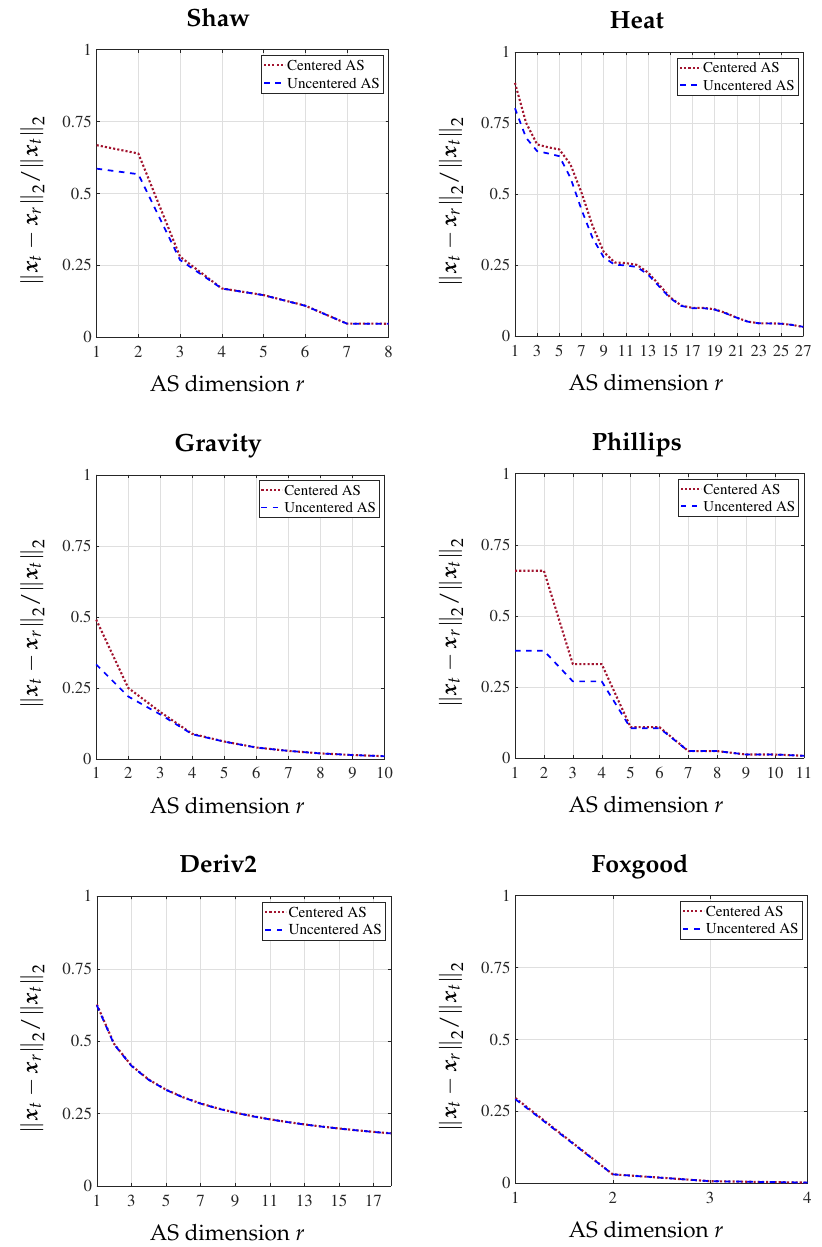
Figure 3. The comparison between centered AS and uncentered AS in recovering the true solution x t . x r is the projection of x t in the active